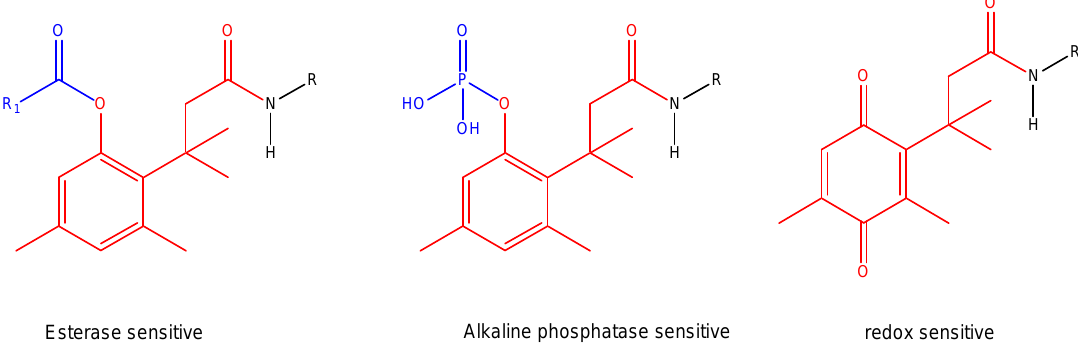
Figure 1 . Tripartite "trimethyl lock"